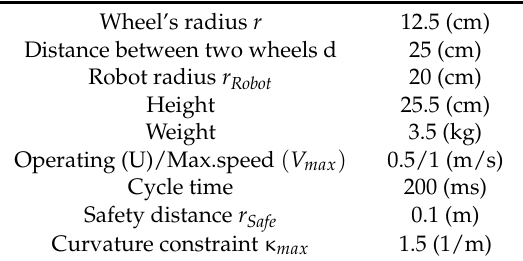
Table 1. The parameters of the mobile robot Dr. Robot X80 (Figure 1) used for the